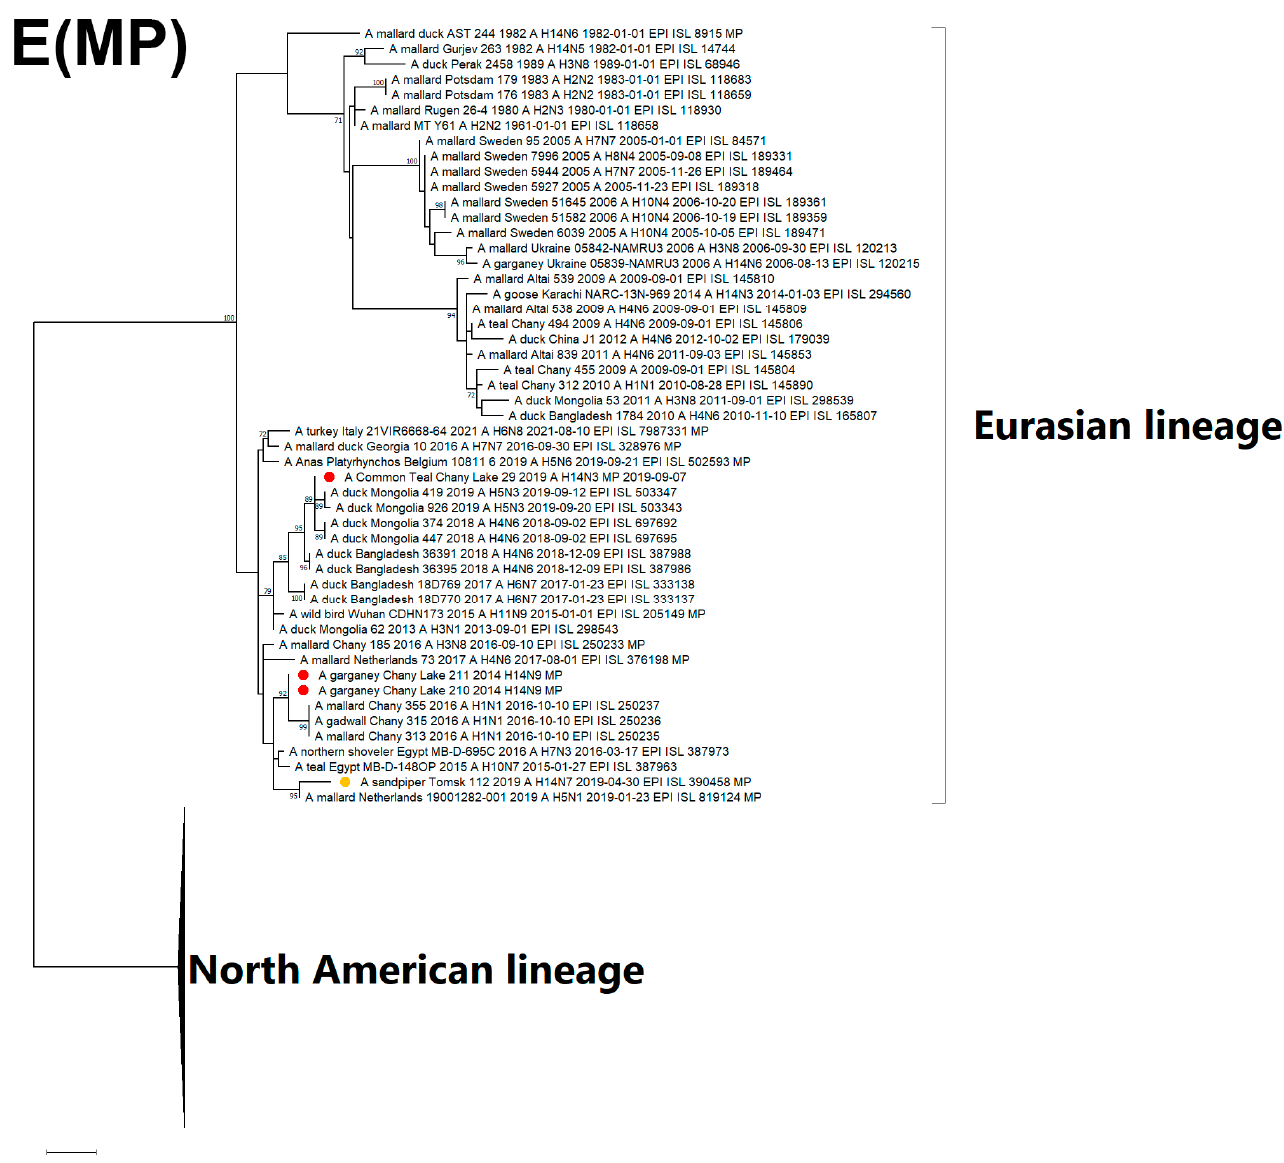
Figure 5. Maximum likelihood phylogenetic tree of internal genome segments: ( A ) PB2, ( B ) PB1, ( C ) PA, ( D ) NP, ( E ) MP of avian influenza viruses ( • —sequences from this study; • —sequence of H14 influenza virus isolated in related region from public database).